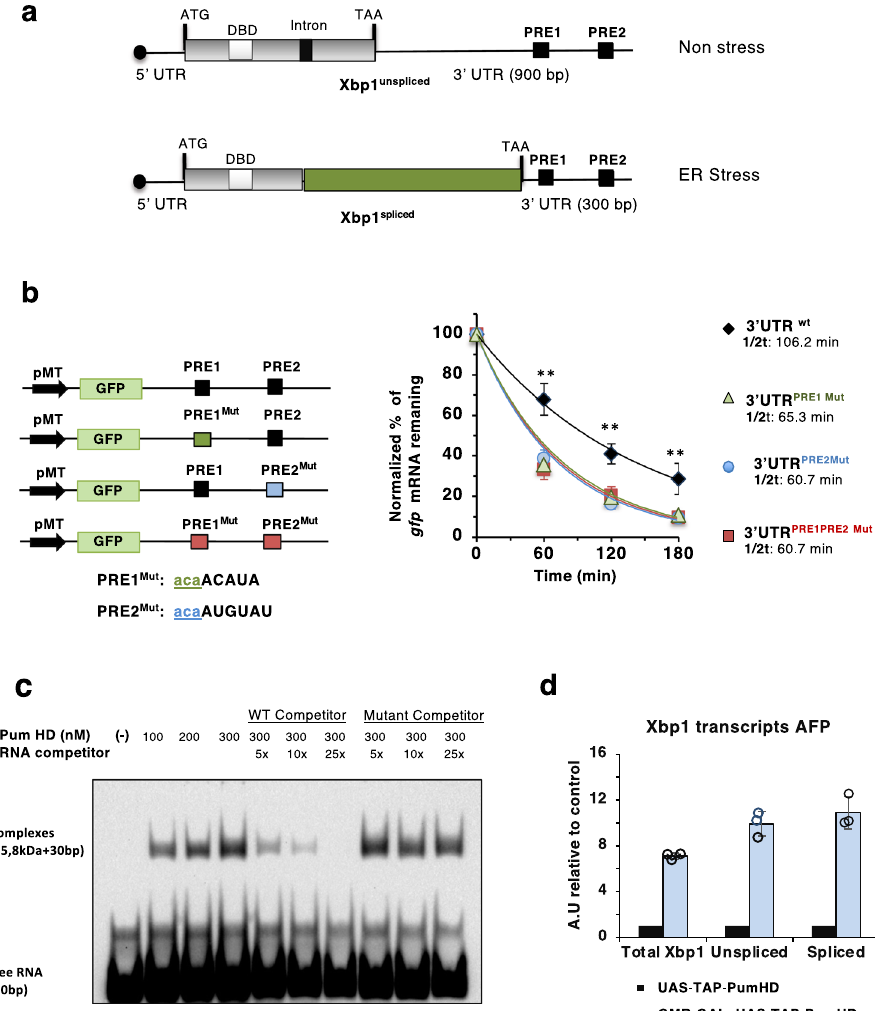
Fig. 1 The 3 ′ UTR of Xbp1 contains cis elements of mRNA stability. a Schematic representation of Drosophila Xbp1 transcripts (unspliced and spliced). ATG (start codon), TAA (stop codon), DBD (DNA binding domain), Intron (23-nt hairpin structure) recognized by Ire1 RNase domain, bp (base pairs). Upon ER stress, Ire1 removal of the intron causes a frame shift to generate Xbp1 spliced . Two Pumilio regulatory elements (PRE1 and PRE2) are present in the 3 ′ UTR of Xbp1. b Xbp1 3 ′ UTR pRM GFP reporters bearing the WT and mutant PREs from the Xbp1 3 ′ UTR. The consensus binding sites UGUA for Pumilio were mutagenized into ACAA for PRE1 Mut and PRE2 Mut ; pMT, metallothionein promoter. Stability of the GFP reporters was assessed after actinomycin D addition [5 µ g/ml], by quantitative RT-PCR (qRT-PCR), using primers speci fi c for gfp and rp49 mRNAs (control). Levels of mRNA reporter were normalized to those of rp49 mRNA. Data are presented as mean ± SD. n = 3 of biologically independent experiments. wt, black; PRE1 Mut , green; PRE2 Mut , blue; PRE1PRE2 Mut , red. One-way ANOVA followed by Tukey´s HSD multiple comparisons test was used to calculate signi fi cant differences between wt and mutant PREs. 60 min: ** p = 0.01; 120 min: * p = 0.03, * p = 0,015; ** p = 0.009; 180 min: * p = 0.029, * p = 0,026, * p = 0,018. c Electrophoretic mobility shift assay (EMSA) showing binding of puri fi ed hPUM1-HD, with the PRE1 of the Xbp1 3 ′ UTR. hPUM1-HD (38,5 kDa) binds the RNA oligo containing the WT PRE1 sequence (30 nt), as seen by appearance of a slower migrating band corresponding to the RNA-protein complexes. The binding selectivity of hPUM1- HD to the RNA oligo was examined by the presence of increasing concentrations of an unlabeled RNA oligo competitor (30nt), containing the WT or the mutated (UGUA to ACAA) target sequence for Pumilio binding. n = 2 of independent experiments. d Quantitative RT-PCR using primers speci fi c for PumHD control pull downs. Results show interaction between Xbp1 spliced and Xbp1 unspliced transcripts and PumHD. Data are presented as mean ± SD. n = 3 replicates from one RNA pulldown assay. Source data for fi gures b-d are provided as a Source Data fi